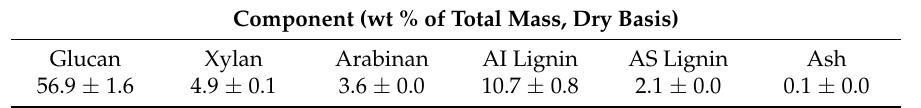
Table 5. Composition of the BRM sorghum